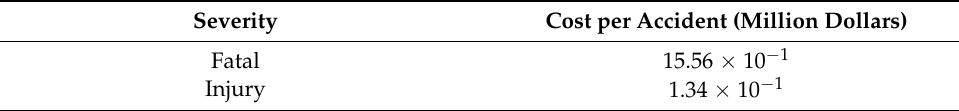
Table 3. Cost per fatal and injury causing